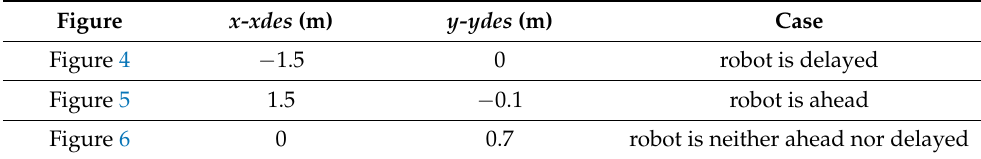
Table 1. Initial robot positions and their corresponding figures. Figure x-xdes (m) y-ydes (m) Case Figure 4 − 1.5 0 robot is delayed Figure 5 1.5 − 0.1 robot is ahead Figure 6 0 0.7 robot is neither ahead nor delayed The experiment is delayed for only 7.5 s, in order to see the transients more clearly. For all figures, NDEAT curves are drawn with solid lines, SDEAT with dashed lines and TT with dash-dotted